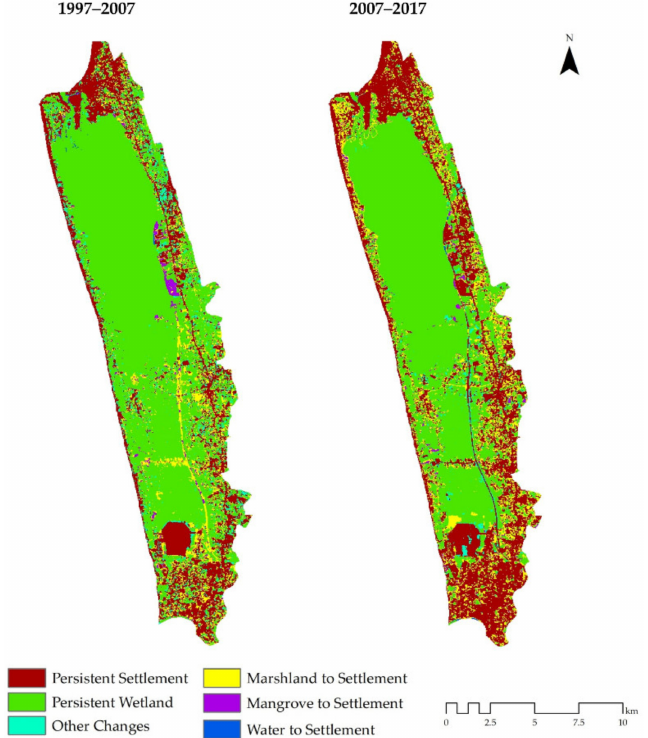
Figure 4. Spatial distribution of wetland loss in the MMNL due to urbanization (settlement expan- sion). ( left ) 1997 to 2007; and ( right ) 2007 to 2017. Wetland includes water, mangrove, and